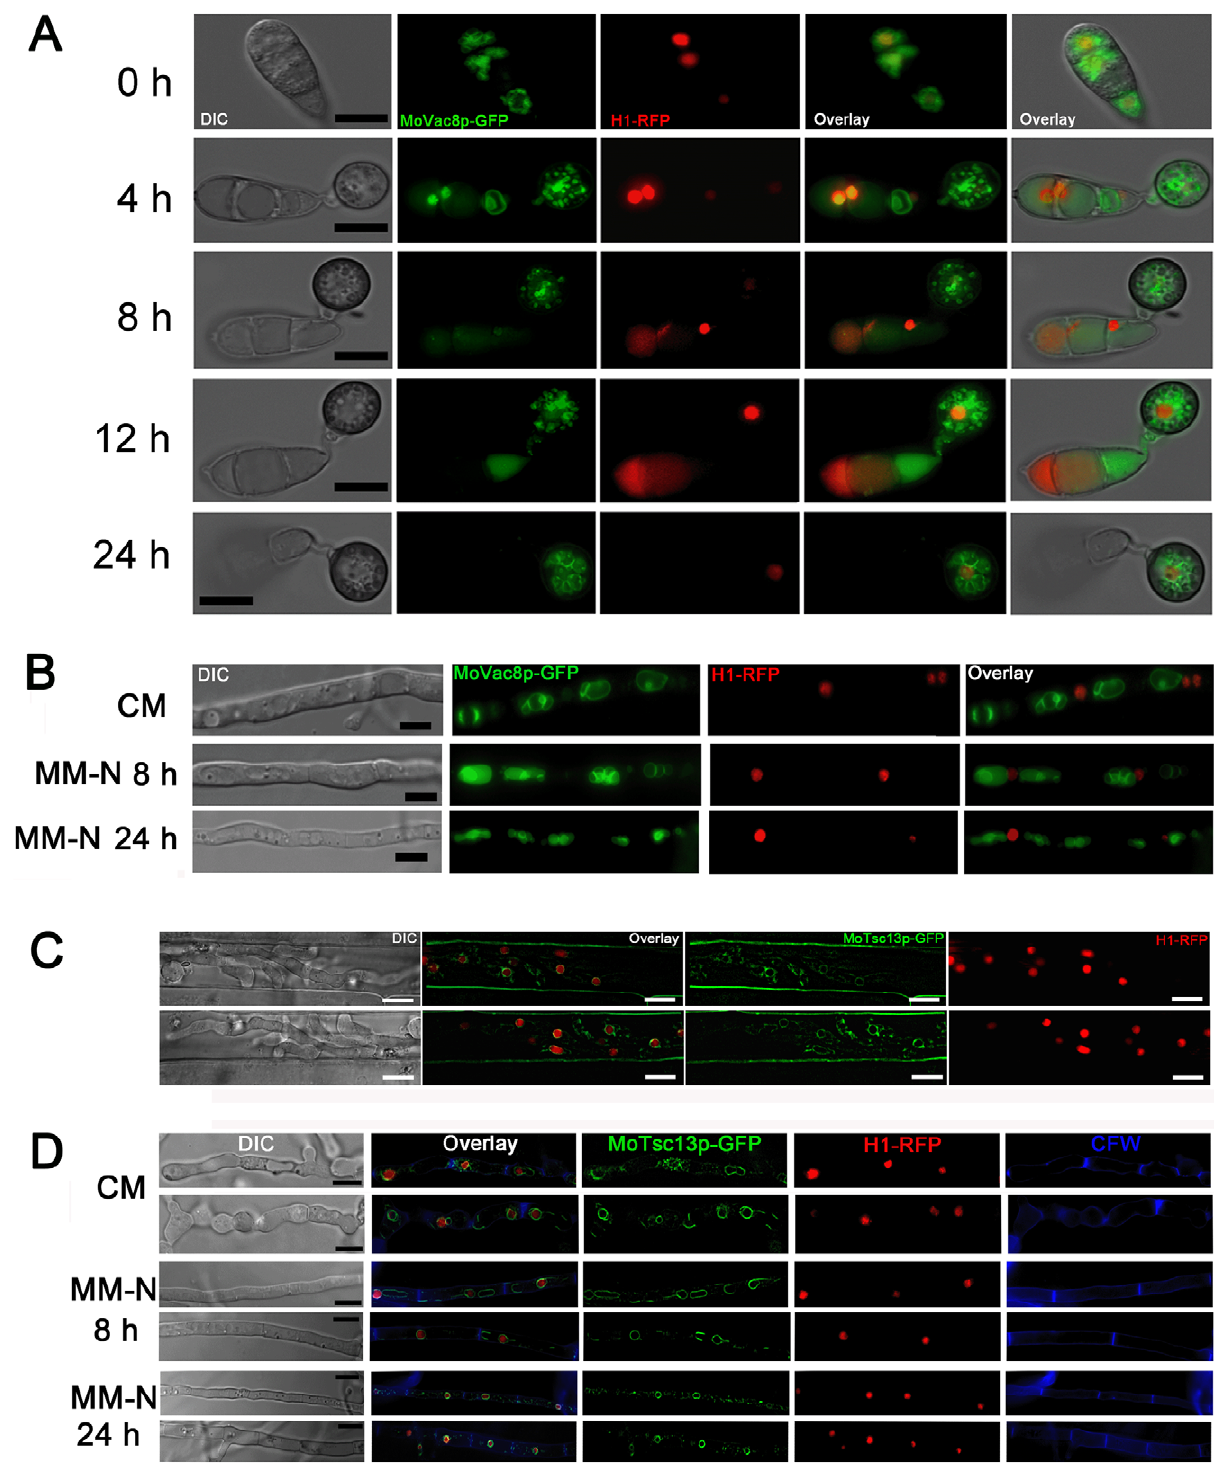
Figure 6. Nuclear-vacuolar (NV) junctions are not present in M.oryzae during appressorium development or starvation stress. ( A ) Time course live cell imaging of appressorium development in M. oryzae expressing both MoVAC:GFP and H1:RFP . ( B ) Micrographs of hyphae of M. oryzae expressing both MoVAC:GFP and H1:RFP . M. oryzae was grown in nutrient-rich medium (CM) or nitrogen stress minimal medium (MM-N) for the indicated period of times, and hyphae collected for epifluorescence microscopy. Hyphae cultured in CM for 40 h were washed with distilled water, before being transferred into MM-N. ( C ) MoTsc13p is associated with perinuclear and peripheral ER membrane in invasive hyphae. M. oryzae expressing both MoTSC13:GFP and H1:RFP was inoculated onto rice sheath epidermis for 36 h before epifluorescence microscopy. ( D ) Distribution of MoTsc13p-GFP is not affected byenvironmental nutritionalstatus.Hyphae of M.oryzae expressing both MoTSC13:GFP and H1:RFP were growninCMor MM-N for epifluorescence microscopy. Pictures shown are representatives of at least 30 different hyphae cell compartments analyzed for each time point. Scale bar=10 m m.